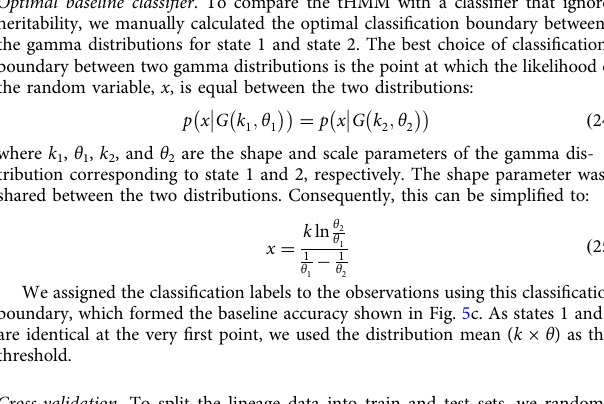
Figure 6 uses the fi rst 4 states of Supplementary Table 3 as the parameter set for the emissions matrix to simulate varying state numbers in the BIC calculation. Varying emission differences . To create synthetic data with subpopulations of varying dissimilarity (Fig. 5), we use the phase-speci fi c parameters, with the values for the G1 phase gamma scale parameter for state 1 varying over [4, 20]. This results in an increase in the Wasserstein distance between the two cell states, allowing us to measure state assignment accuracy for different dissimilarity amounts between the two states. Likewise, for Supplementary Figs. 6, 7, we simulated the overall cell lifetime and varied the gamma distribution scale para- meter from 1 to 8 for state 1.